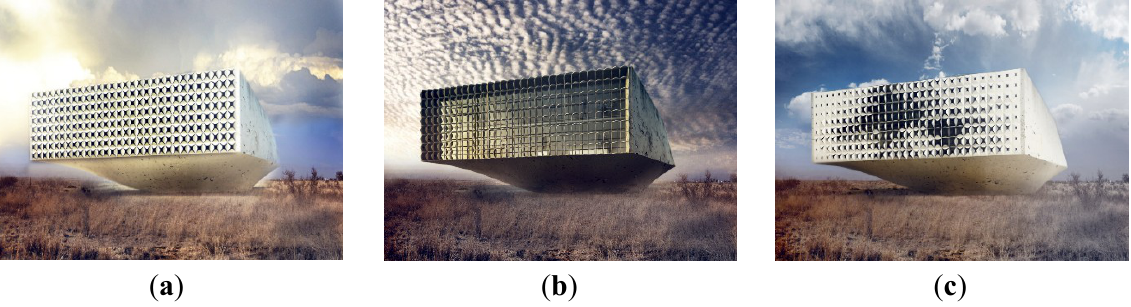
Figure 7. Adaptive dynamic shading module mounted in the exterior façade of a museum in Texas ( a ) at noon, ( b ) at twilight, and ( c ) adapted for a varying architectural program behind the